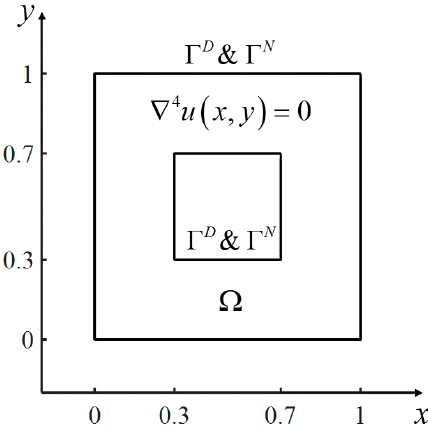
Figure 11. Schematic diagram of the computational domain in case 5.